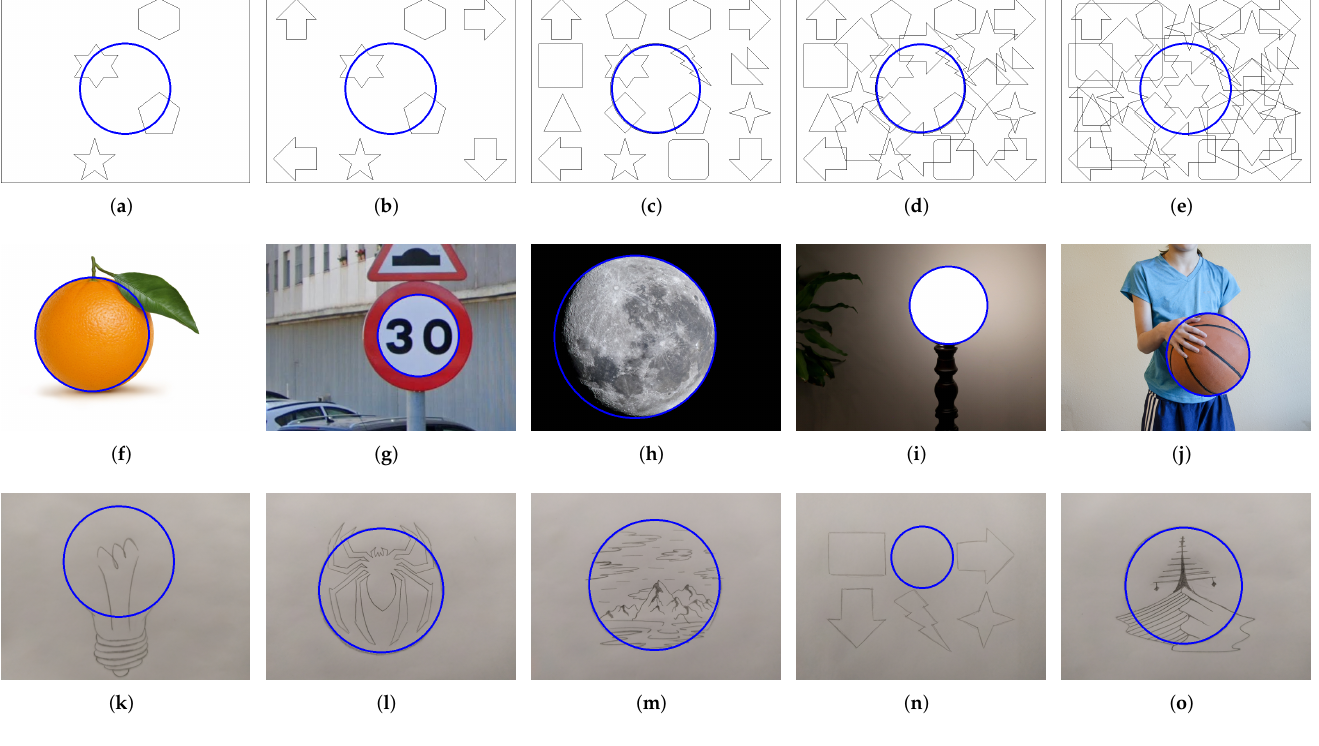
Figure 12. Output images with superimposed detected circles corresponding to the fitness evolution trends presented in Figure 13. Synthetic images ( a – e ). Real images containing circular objects ( f – j ). Real images with hand-drawn figures ( k – o